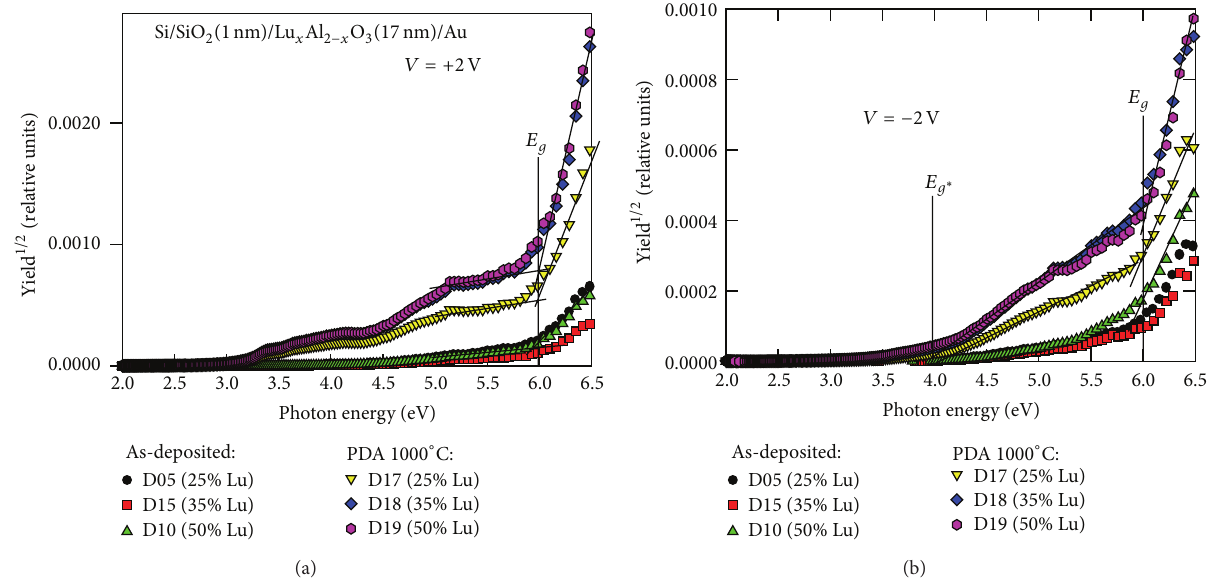
Figure 13: Square root of the PC yield as a function of photon energy in Si/SiO 2 /Lu 𝑥 Al 1−𝑥 O 3 /Au capacitors with different concentration of lutetium in the insulating layer as measured under positive (a) and negative (b) bias of 2 V applied to the top Au electrode. The results are shown both for the as-deposited samples as for those supplementally annealed at 1000 ∘ C in N 2 for 1min prior to metallization. The inferred spectral thresholds of the intrinsic PC are indicated by vertical lines 𝐸 𝑔 and 𝐸 𝑔 ∗ .